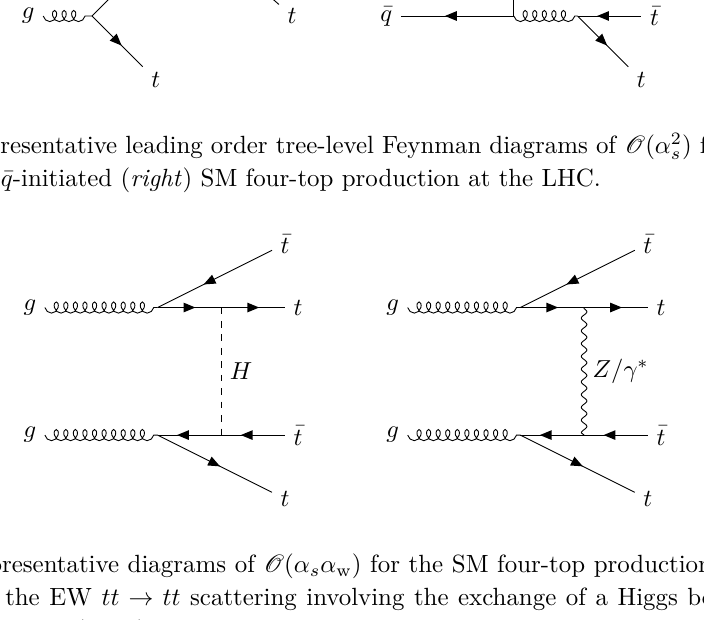
Figure 2 . Representative diagrams of O ( α s α w ) for the SM four-top production at the LHC. The diagrams show the EW tt → tt scattering involving the exchange of a Higgs boson ( left ) or a Z - boson/virtual photon ( right